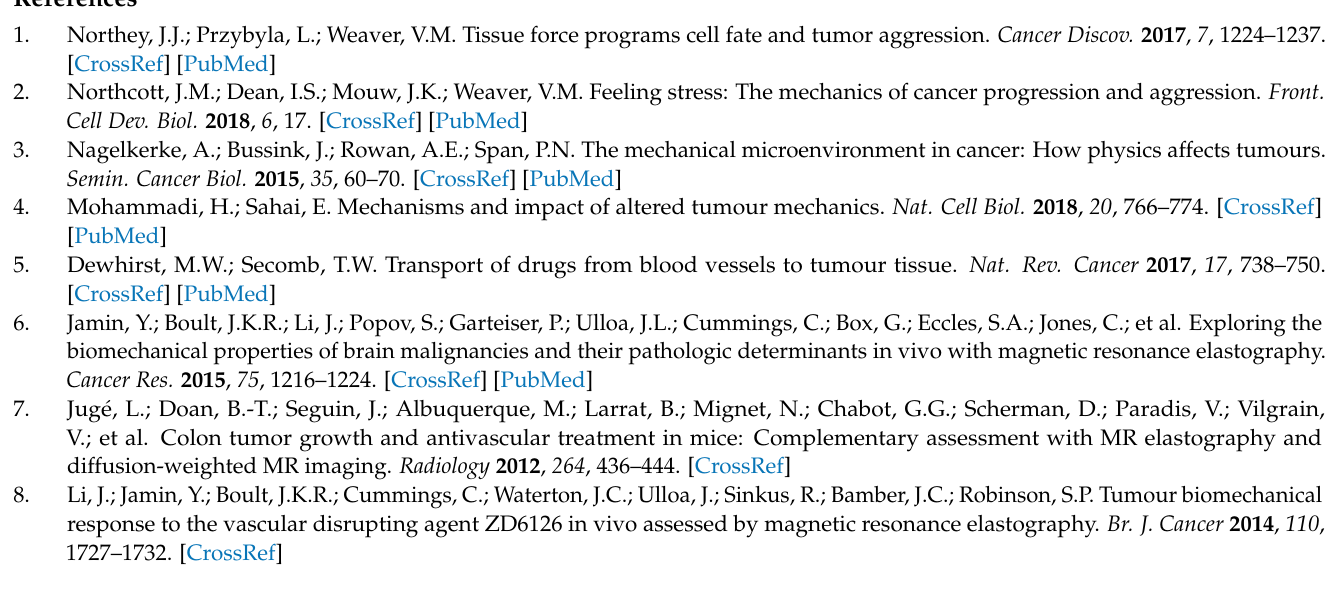
Figure A3. Representative histology sections stained with H&E and CD31 antibody. MDA-MB-231 and U-87 MG tumours treated with ZD6126 and vehicle are shown. The dashed black lines show the necrotic regions. Insets have been magnified to show necrotic and viable cell appearances. CD31 staining has been shown to demonstrate the functionality of ZD6126 on